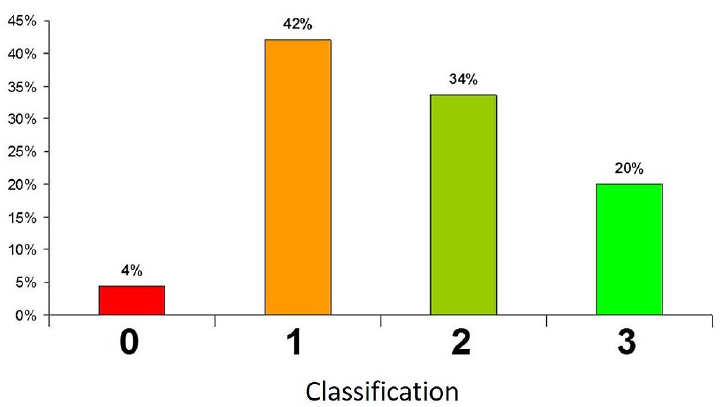
Figure 9. Metal marking classification distribution obtained on large batch of ceramic stoneware products (0 — severe marking, 1 — distinct marking, 2 — slight marking and 3 — no marking).